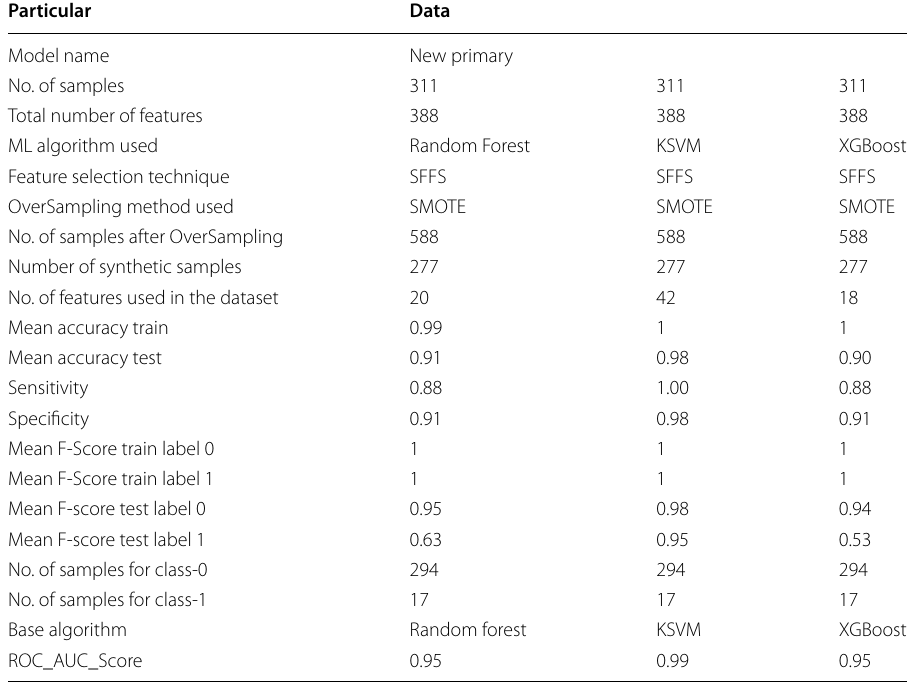
Table 9 Results of the test dataset for the new primary